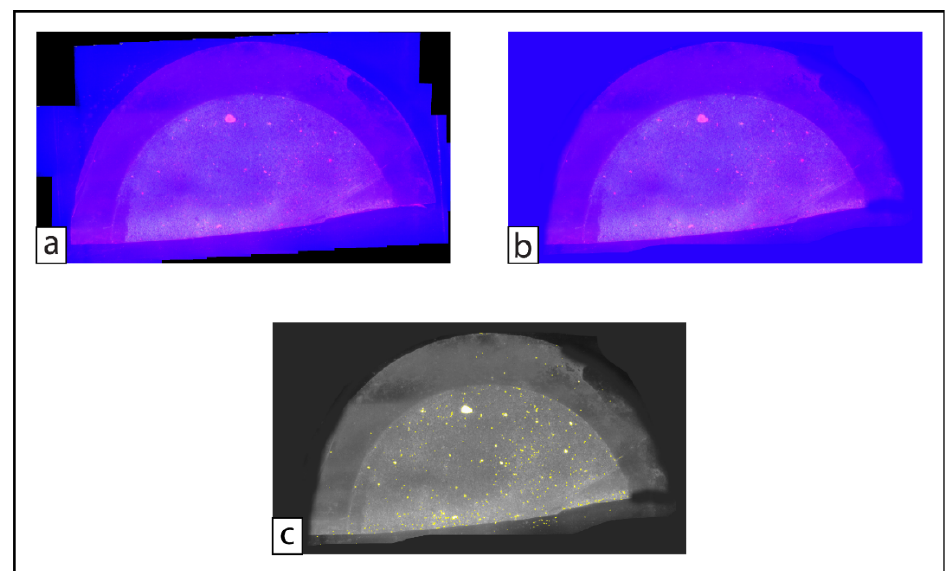
Figure 5. Filter membranes reconstructed and processed. ( a ) The image output from Autostitch. Only the central area of the filter is the actual filtering area, whose pink background could be due to the presence of silt and clay stained by the dye; on the top side of the image, it is still possible to see the original scale of the individual photos taken. ( b ) The brush tool with blue color was used to correct filter imperfections. ( c ) The final output from ImageJ (red channel), in which the identified microplastics are underlined in yellow, allows the postanalysis search of errors or false positives.